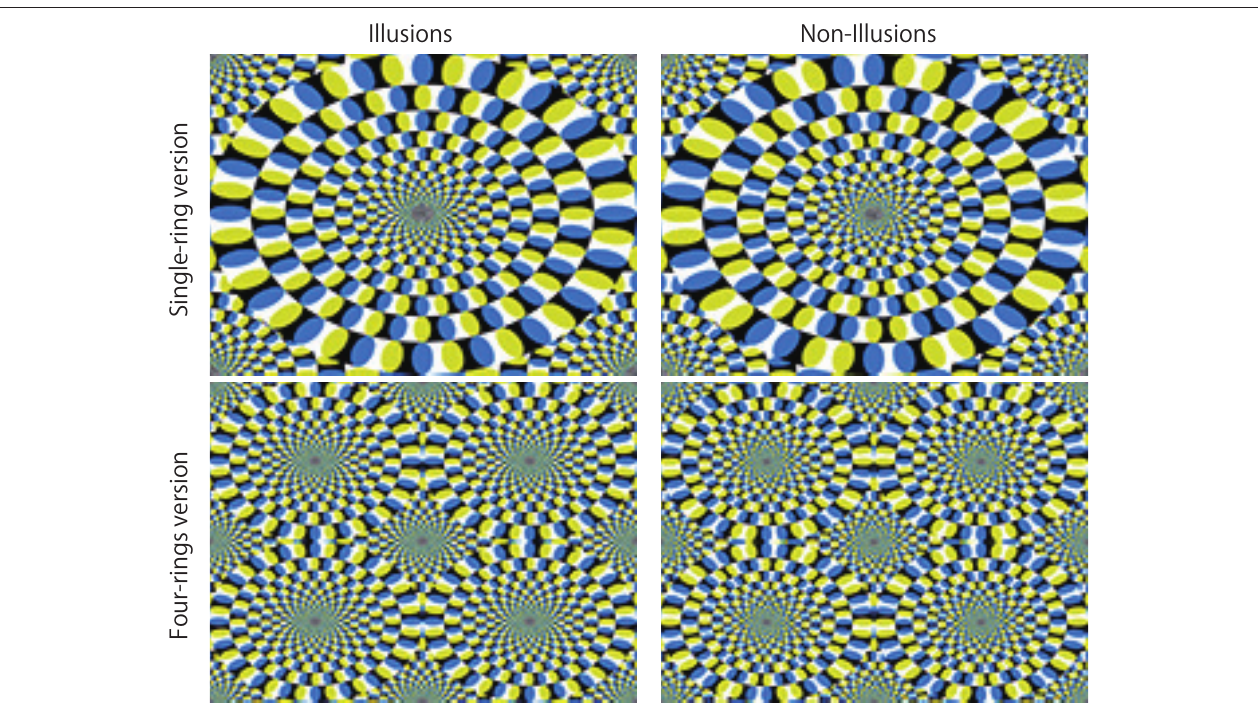
FIGURE 2 | Akiyoshi Kitaoka’s rotating snake illusions (the left 2 panels). In the case of the single-ring version, most people perceive a counter-clock wise motion. In the case of the four-ring version, people perceive clockwise or counter-clockwise motion depending on color alignment. Negative controls (non-illusions) for which people perceive no motion are presented in the right 2 panels. The resolution of all images is width 160 and height 120 pixels. For prediction, the same consecutive 20 images were input to the trained networks. To experience stronger illusory motion perception, please refer to “Akiyoshi’s illusion pages,” http://www.ritsumei.ac.jp/~